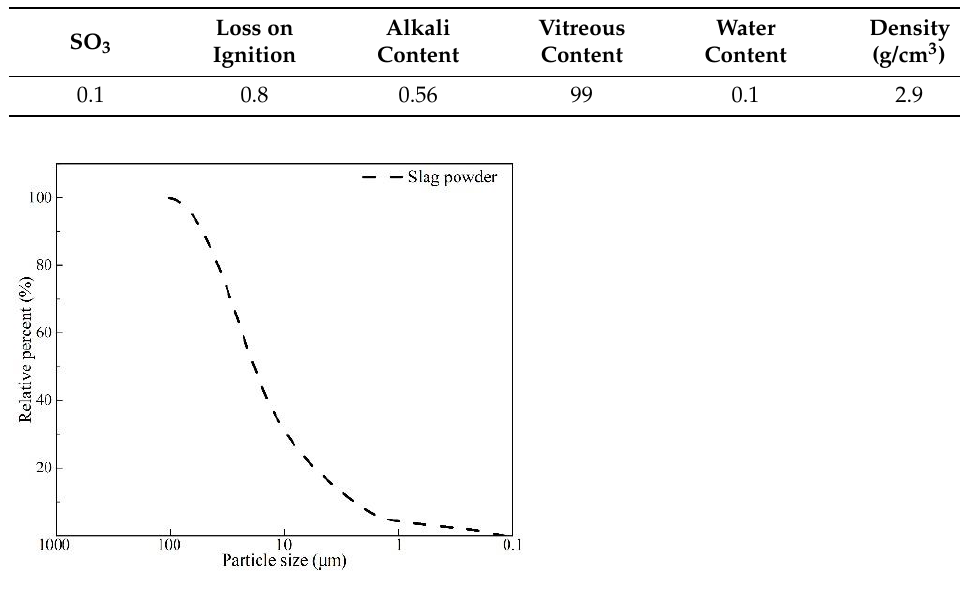
Figure 2. The particle size of the slag.